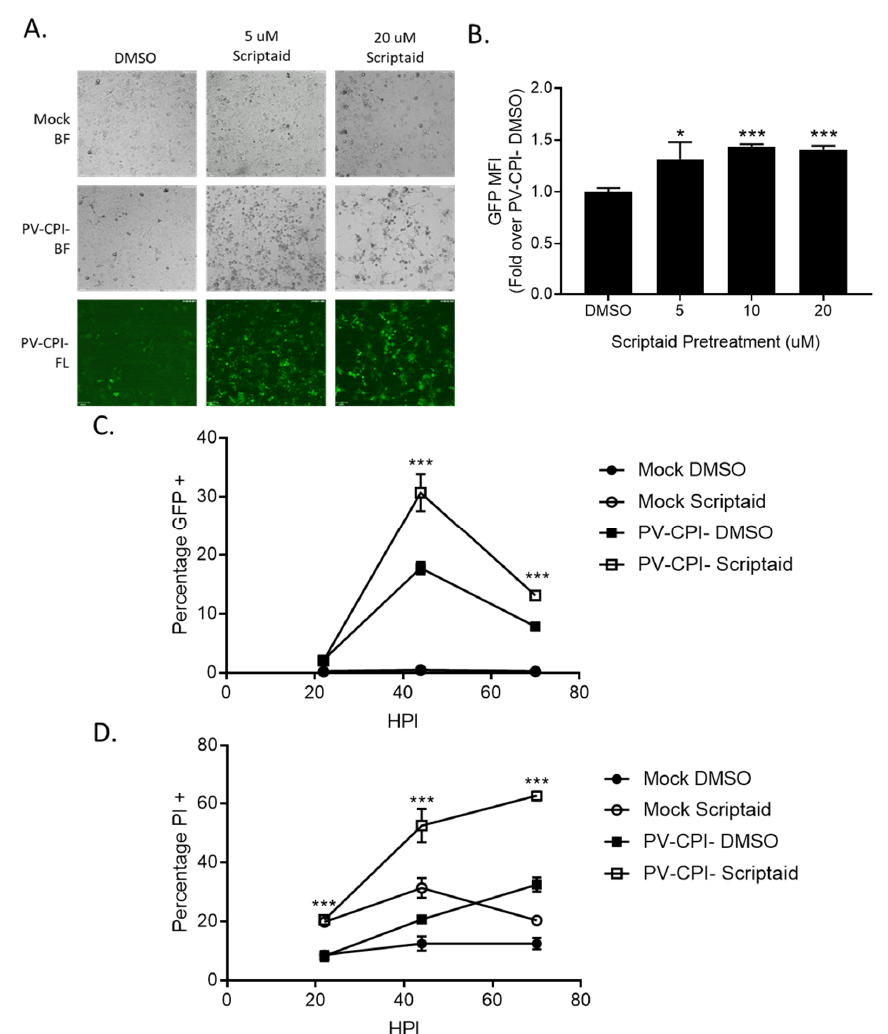
Figure 5. Pretreatment of cells with an HDAC inhibitor increases P / V-CPI- GFP expression and promotes low MOI virus spread. (A , B ) H1299 cells were pretreated with the indicated concentrations of scriptaid or control DMSO for 12 h. Cells were then mock infected or infected with P / V-CPI- at an MOI of 10. After 24 h of culture in media containing either 1 µ M scriptaid or DMSO, 20 × bright field (BF) or fluorescence (FL) images of cells were captured ( A ). Alternatively, cells were analyzed by flow cytometry for GFP expression ( B ). Values are expressed as fold change over DMSO treated virus infected cells set at 1.0. ( C,D ). A549 cells were pretreated with 20 µ M scriptaid or DMSO for 12 h. Cells were then mock infected or infected with the P / V-CPI- mutant at an MOI of 0.05, and cultured in media containing 1 µ M scriptaid or DMSO. At the indicated hpi, cells were harvested and analyzed by flow cytometry for GFP expression ( C ) or PI staining ( D ). For all panels, error bars indicate standard deviation. * and *** indicates p -values of < 0.05 and < 0.001,